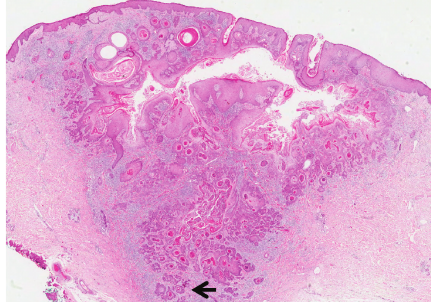
Figure 16: Keratoacanthoma-like SCC: low power magnification showing a crateriform lesion with infiltrative islands and clusters of squamous cells at the base (arrow). (H&E, × 20).